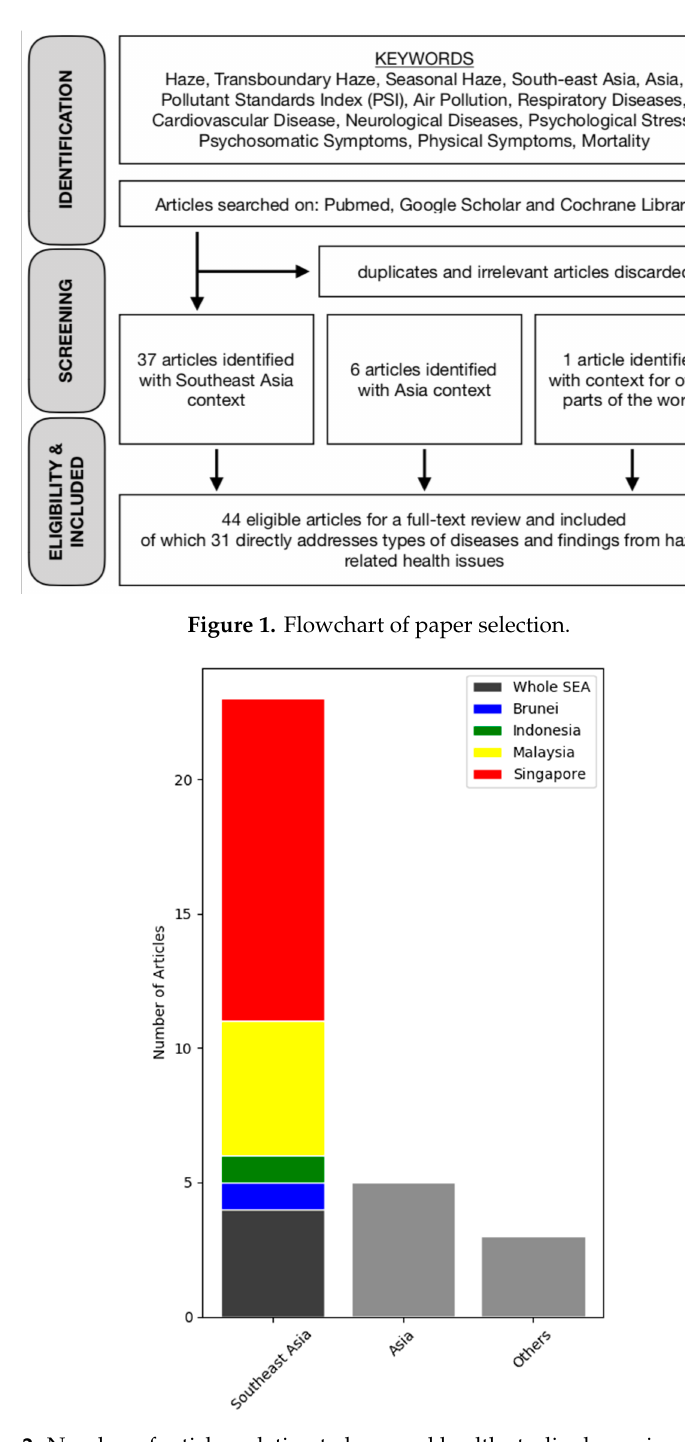
Figure 2. Number of articles relating to haze and health studies by region and country.